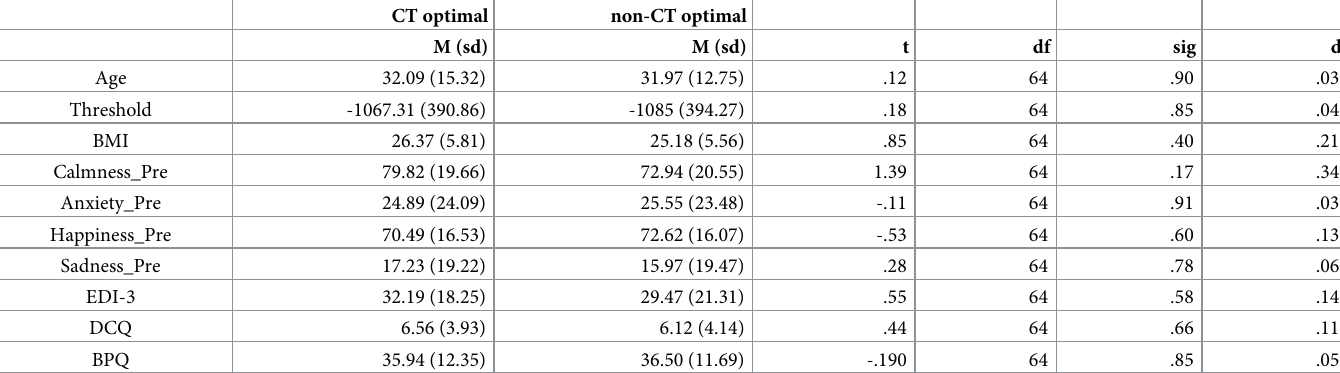
Table 1. Descriptive statistics for Age, SSDT threshold levels, mood at baseline and questionnaire scores in each